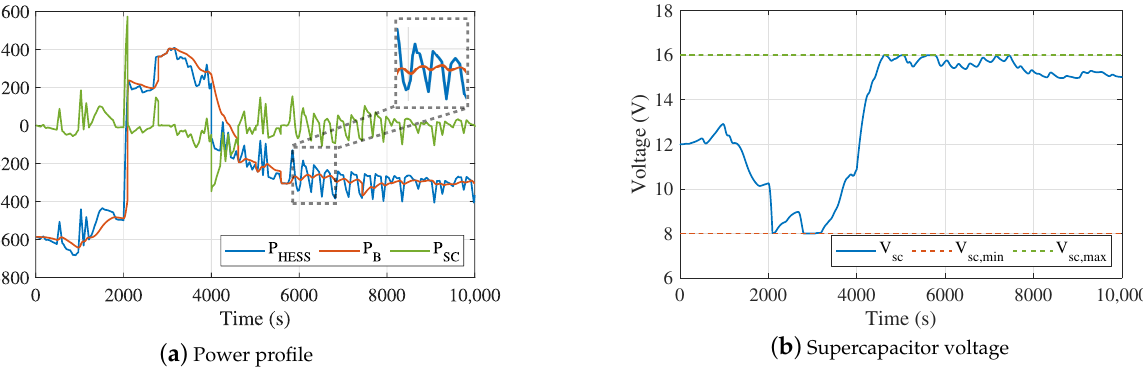
Figure 5. Power filtering and voltage results for the HESS with a first-order LPF ( T = 300 s).